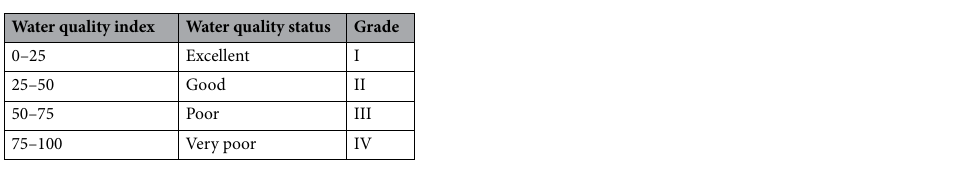
Table 10. Standard water quality grade 4 .